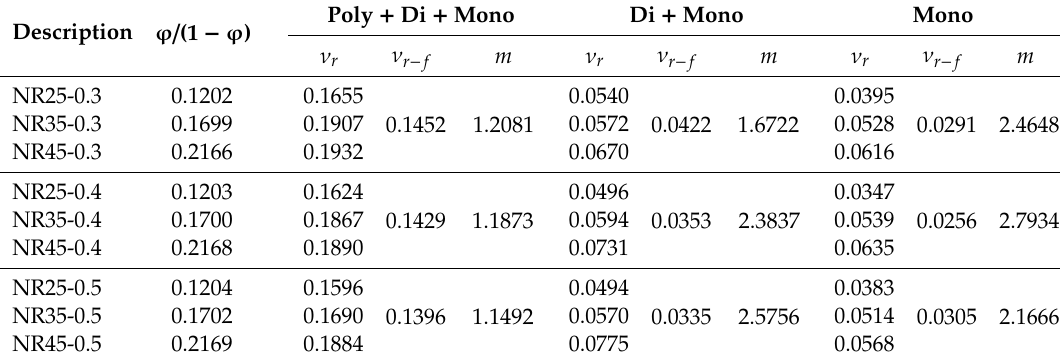
Table 4. Calculated results of the Kraus plot for NR samples before and after sulfide